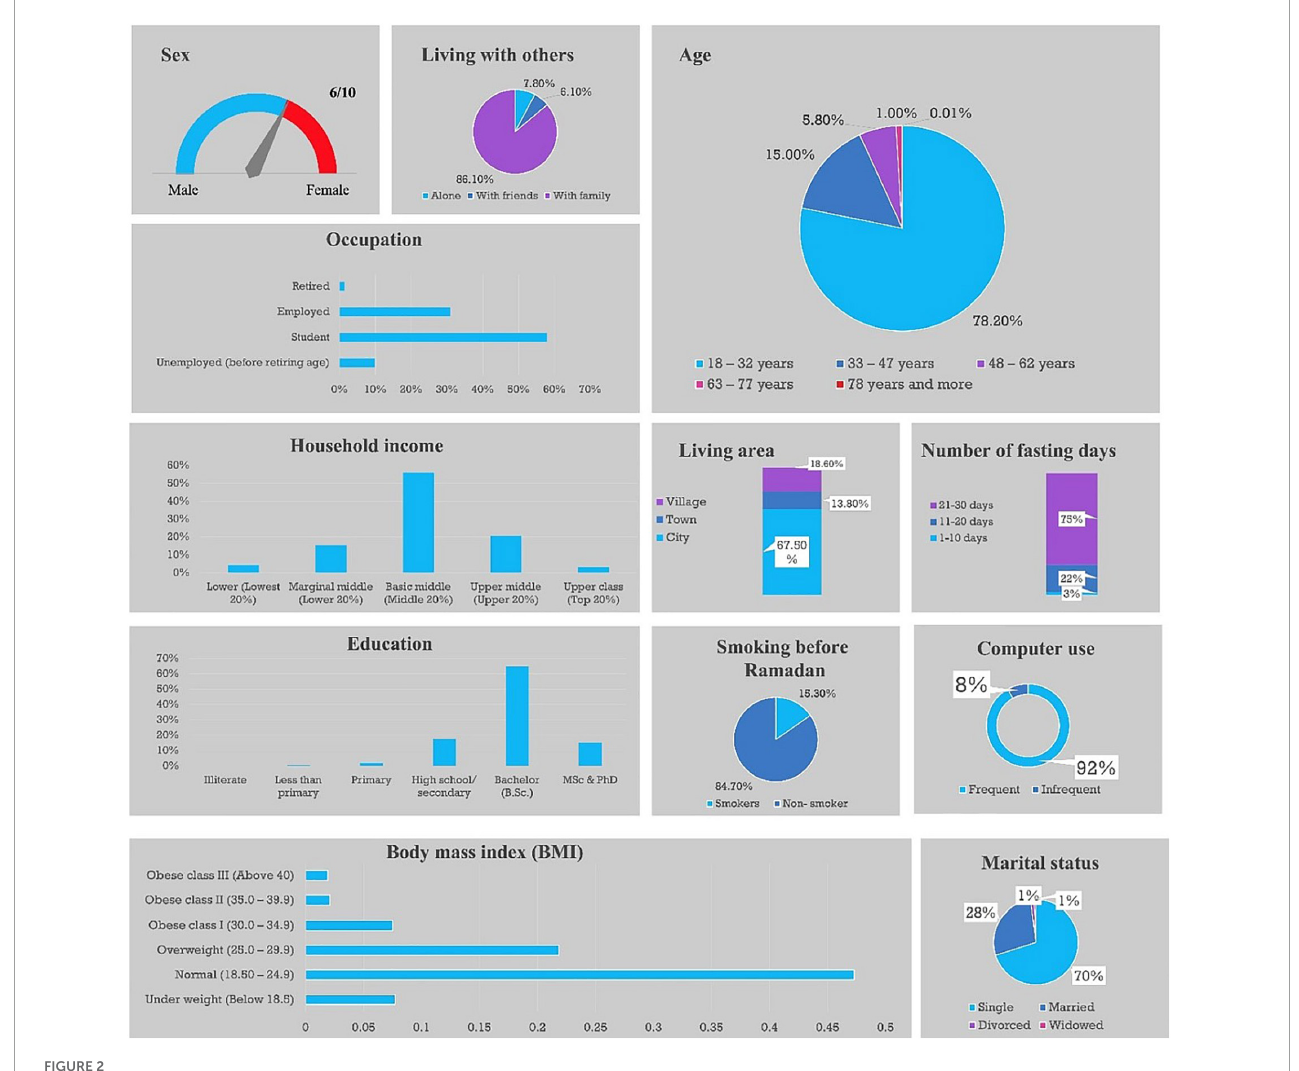
FIGURE2 Sociodemographic characteristics of the 24,500 study participants.